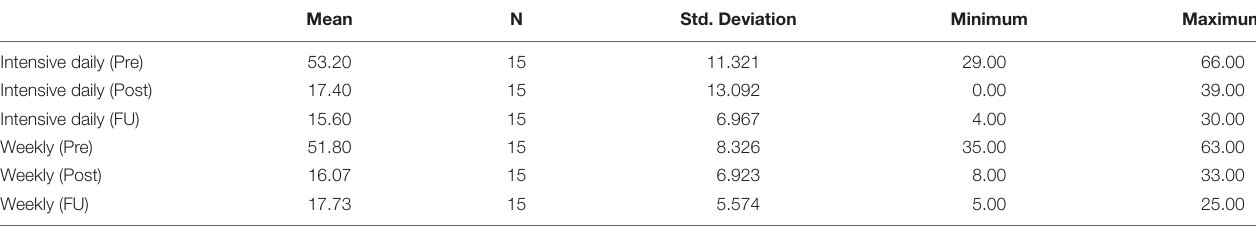
TABLE 1 | Descriptive statistics.